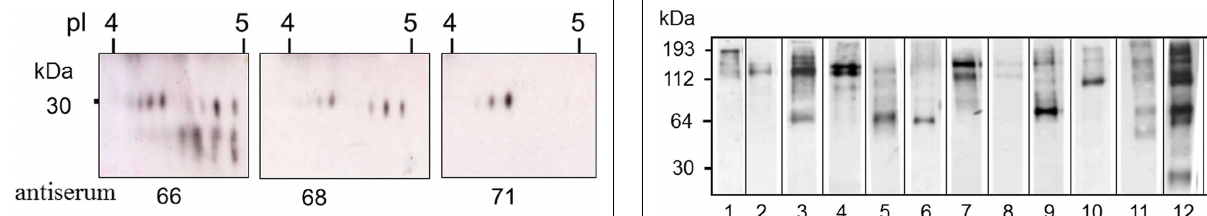
variation than can likely be encoded by a gene family of ∼ 50 members.